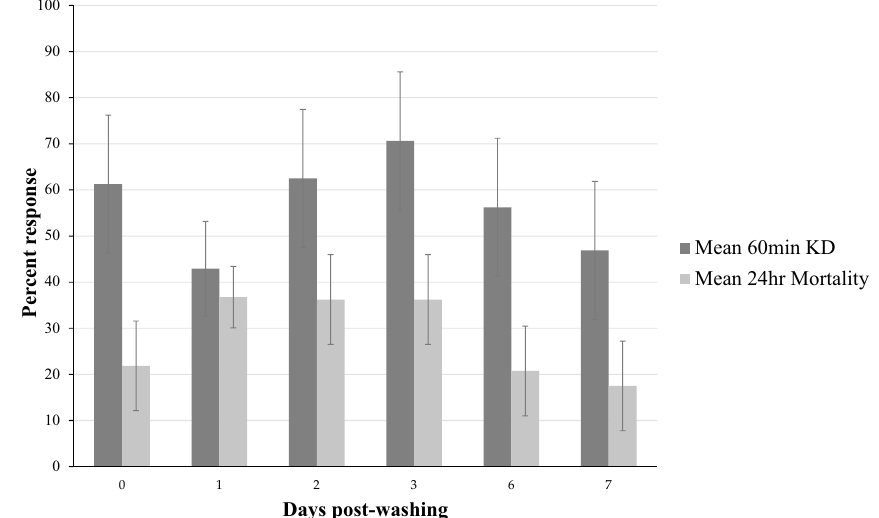
Figure 1. Regeneration time for PBO–permethrin blankets against An. gambiae Kisumu. Each bar in the graph represents a mean of ten replicates of 4 blanket pieces cut from 4 individual whole